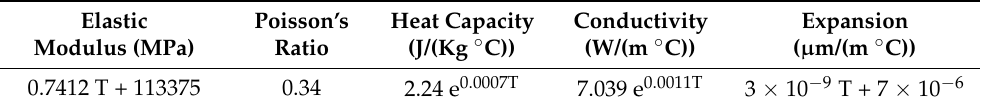
Table 3. Thermomechanical properties of titanium alloy Ti-6Al-4V [25].